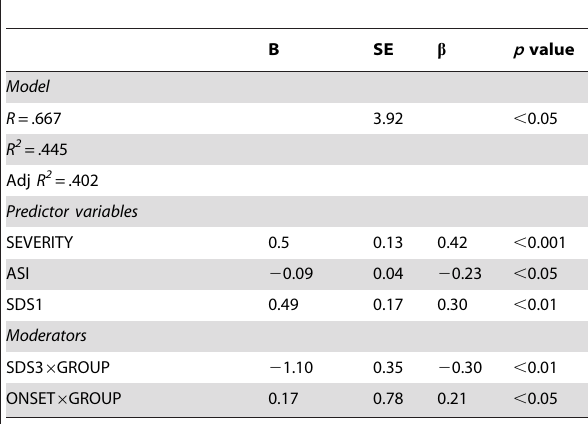
Table 3. Multivariate linear regression presenting the final model with PDSS scores at six-month follow-up as dependent